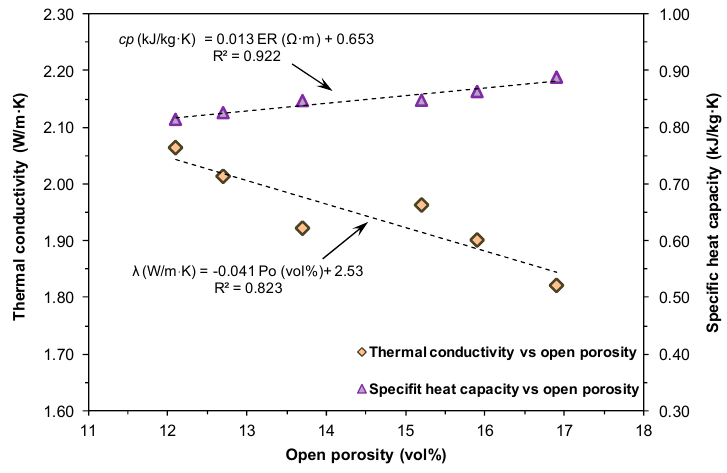
Figure 9. Open porosity/thermal conductivity and open porosity/specific heat capacity relationships for all concrete mixes.